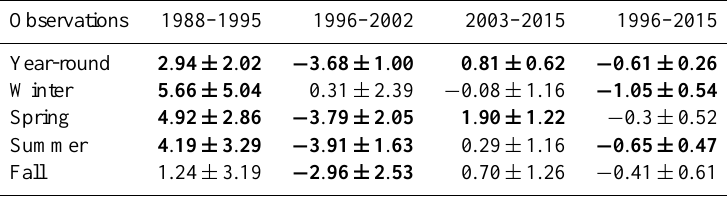
Figure 7. FTIR time series of daily mean HCHO total columns and associated 1 σ standard deviation bars above Jungfraujoch, from Jan- uary 1988 to June 2015. All individual measurements have been re-scaled to 09:00 (see text) and then averaged over the days. The blue curves correspond to the functions fitted to all daily means (including trend component and seasonal modulation) by the bootstrap method of Gardiner et al. (2008), over the 1988–1995, 1996–2002 and 2003–2015/06 time periods, inclusively. Table 2. Trends of daily mean 09:00-scaled HCHO total columns derived from the ground-based FTIR observations at the ISSJ, calculated over the 1988–1995, 1996–2002, 2003–2015 and 1996–2015 time periods by the bootstrap resampling tool. These trends are calculated using either year-round or seasonal (over DJF, MAM, JJA and SON, respectively) observations. They are expressed in annual rate of change (%year − 1 ) relative to the 1988.0, 1996.0 and 2003.0 columns modeled by the bootstrap tool. The trends significant at the 2 σ confidence level are in